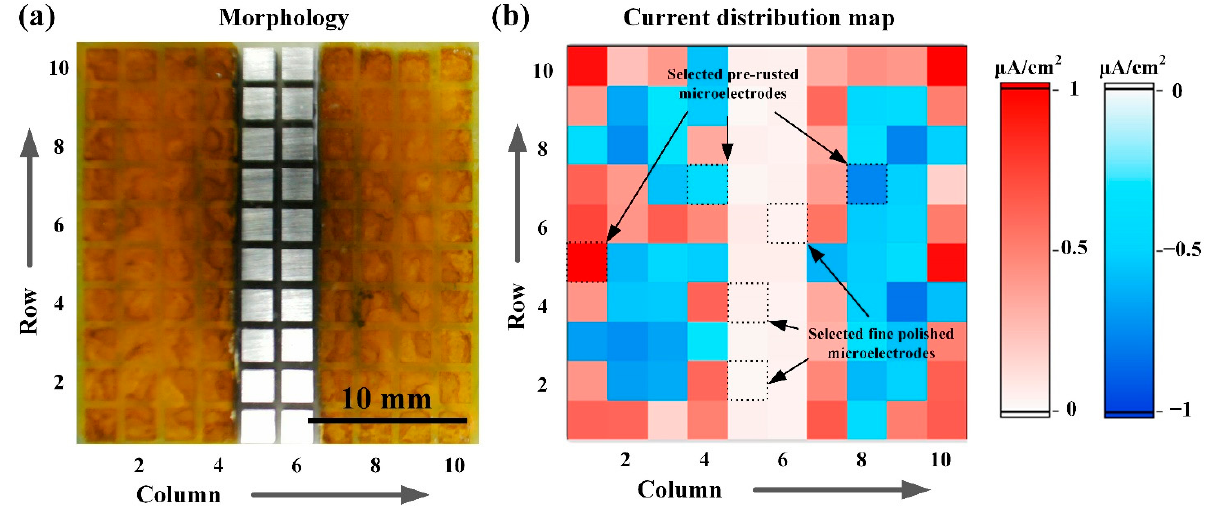
Figure 6. The ( a ) photo and ( b ) current distributions on the WBE in carbonated SCPS.